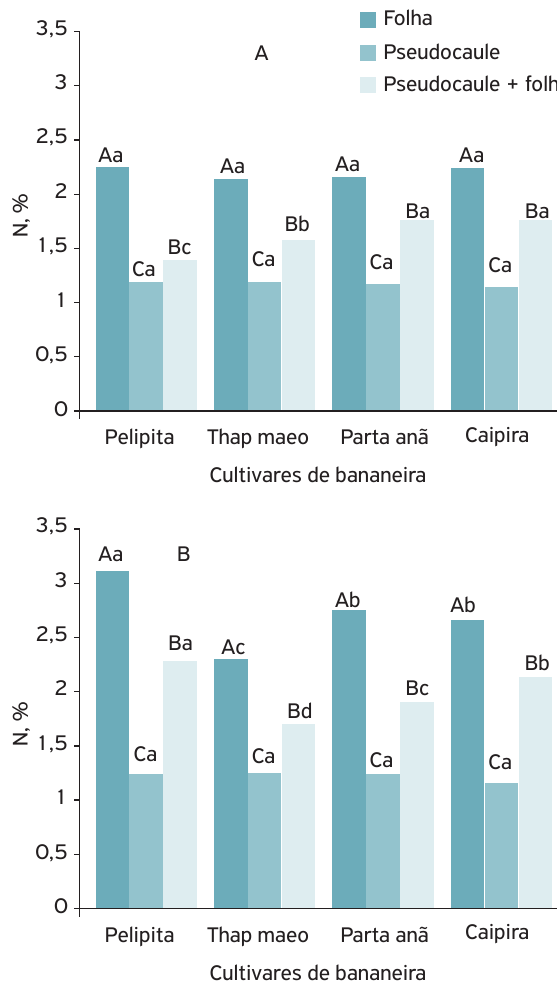
Figura 5. (A) Teores de Zn, mg kg -1 , presente no substrato à base de resíduos de bananeira (pseudocaule, folha e pseudocaule + folha) de quatro cultivares de bananeira (Thap maeo, Prata anã, Pelipita e Caipira) antes de sua colonização pela linhagem 09/100 de Pleurotus ostreatus e após 49 dias de incubação (B) Teores de Zn (mg kg -1 ) presente no substrato formulado à base de quatro cultivartes de bananeira após 49 dias de incubação. Letras maiúsculas comparam médias dentro de um mesmo cultivar de bananeira; letras minúsculas comparam médias dentro de cada tipo de resíduo. Médias seguidas de letras iguais não diferem entre si (Tukey, 5%) (Média de duas repetições).